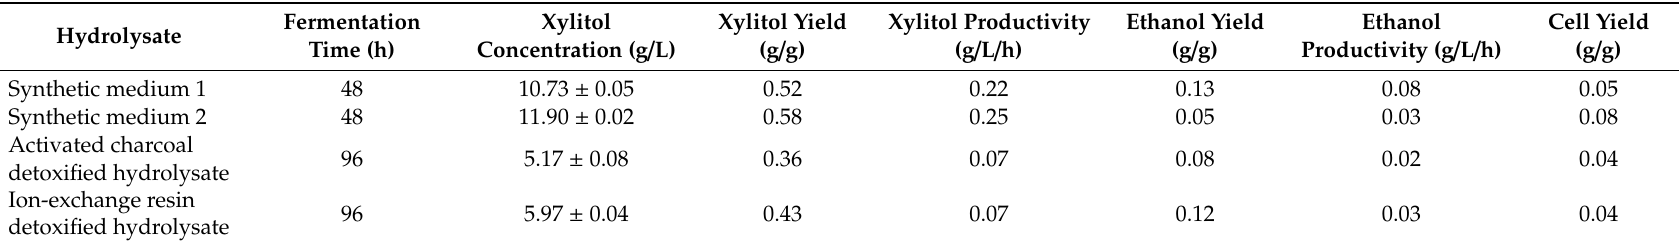
Ethanol Cell Yield Productivity (g / L / h) (g / g)